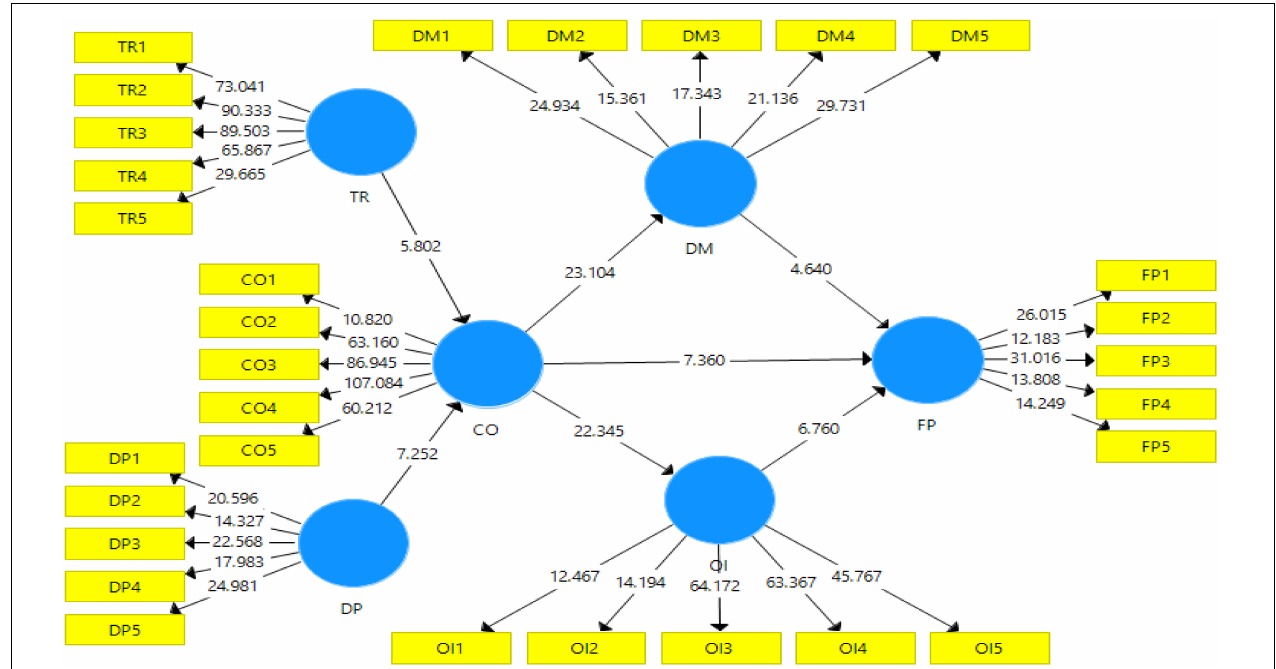
FIGURE 3 | Output of structural model bootstrapping. “CO, coopetition; DP, dependency; DM, decision-making; TR, trust; OI, open innovation, and FP, firm